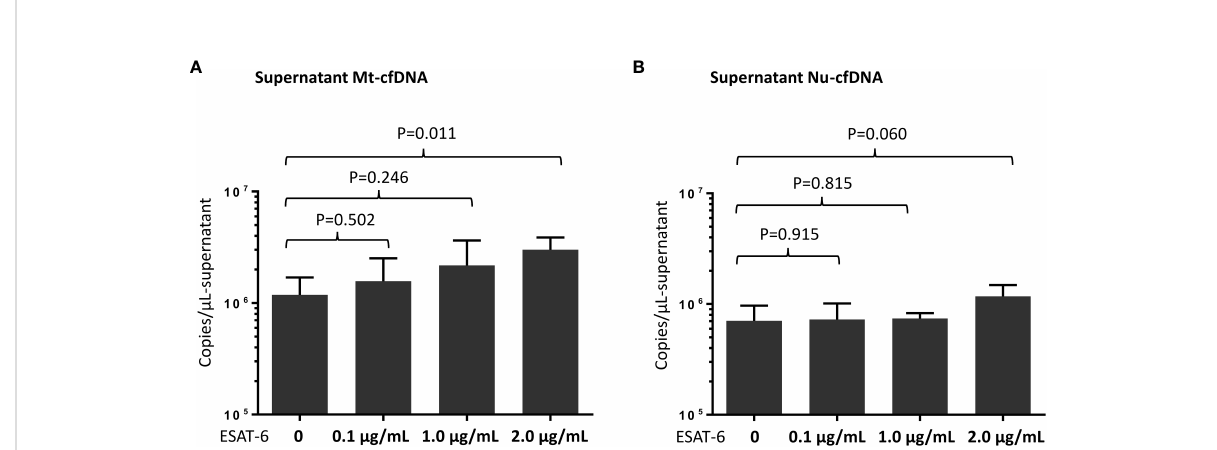
FIGURE 4 Measurement of mitochondrial cell-free DNA (Mt-cfDNA) (A) and nuclear cell-free DNA (Nu-cfDNA) (B) in supernatants from phorbol 12- myristate 13-acetate (PMA)-treated human leukemic cell culture after stimulation by recombinant 6 kDa early secretory antigenic target (ESAT- 6) protein (at concentrations of 0, 0.1, 1.0 and 2.0 µg/mL). Data are presented as the mean ± standard deviation, and n=4 at every concentration